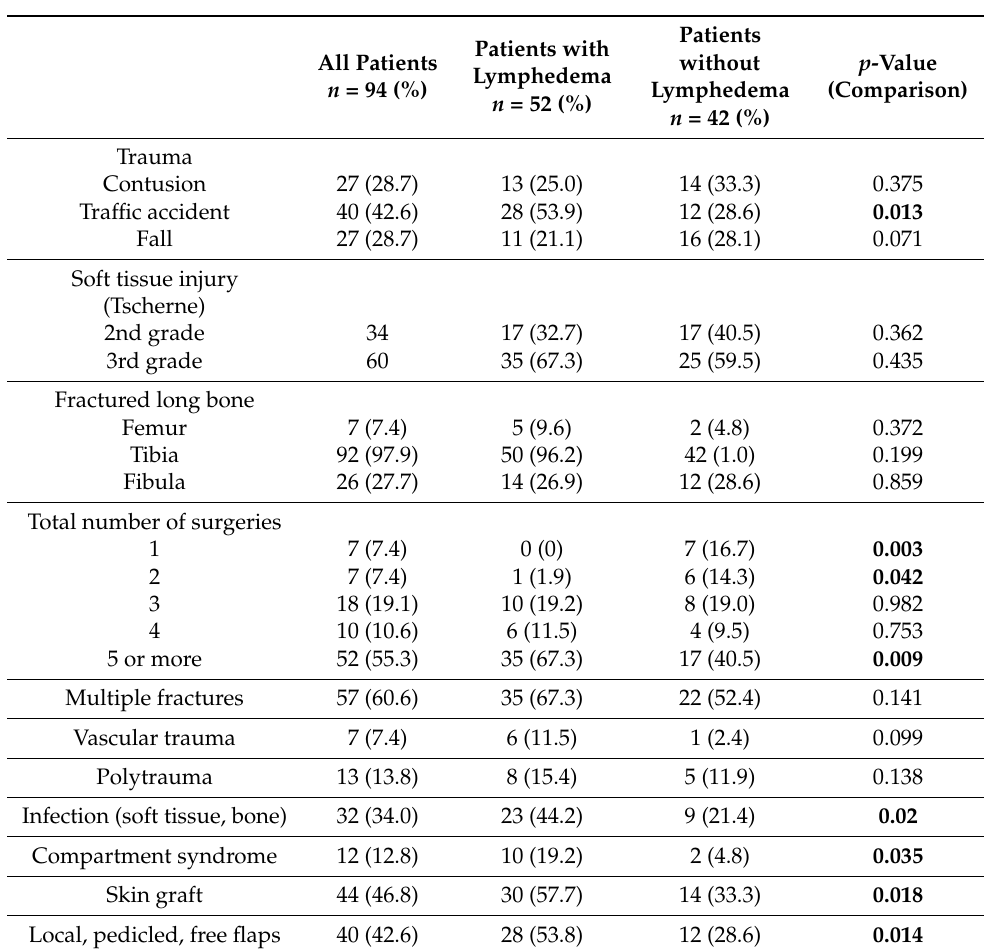
Table 2. Trauma characteristics.